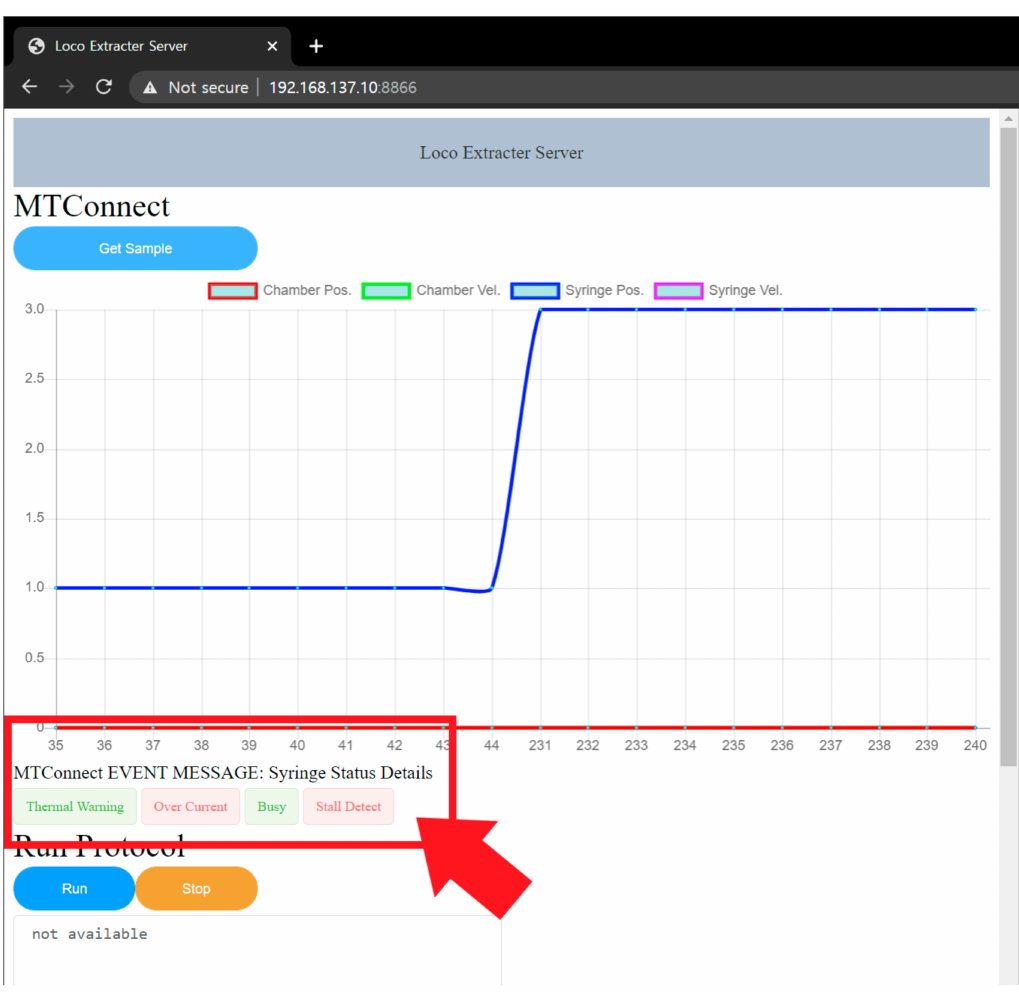
Figure 12. MTConnect client web application with failure message.